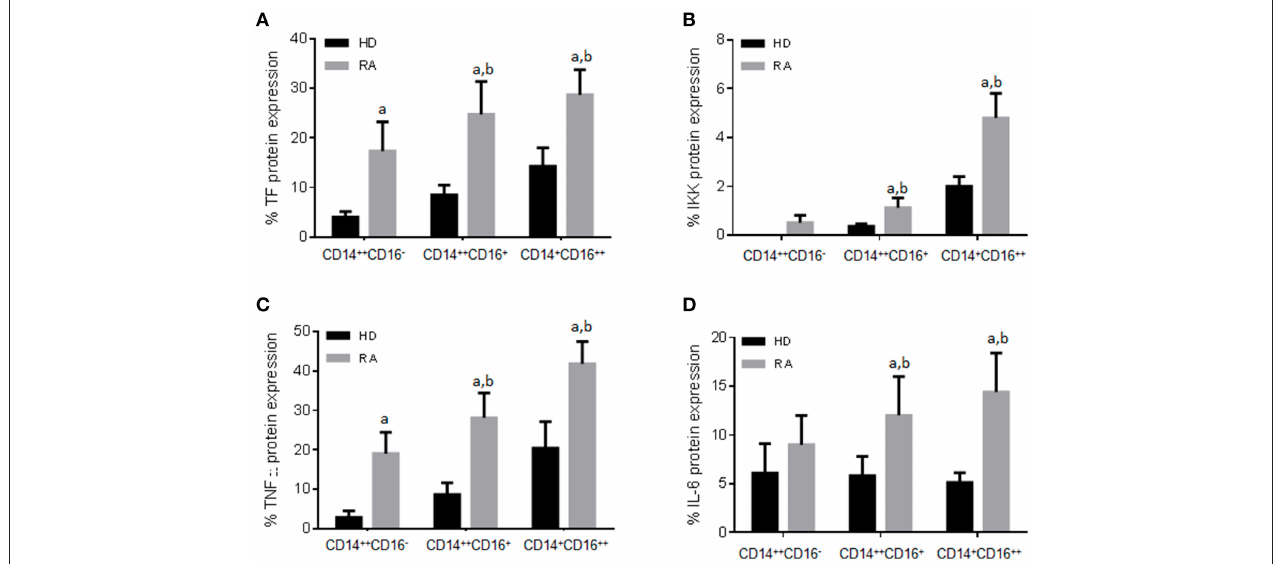
FIGURE 2 | Different protein expression of pro-thrombotic and inflammatory factors in RA monocyte subtypes. (A–D) Protein expression of Tissue factor (TF), I κ B kinase (IKK), Tumor necrosis factor (TNF) and interleukin 6 (IL-6) in the three subpopulations of monocytes in RA and HDs measured by flow cytometry. Data are presented as mean ± SD, n = 50 RA patients and 33 HDs. Paired t -test was performed a indicates significant differences vs. HDs, b indicates significant differences vs. CD14 ++ CD16 − RA monocytes ( p <